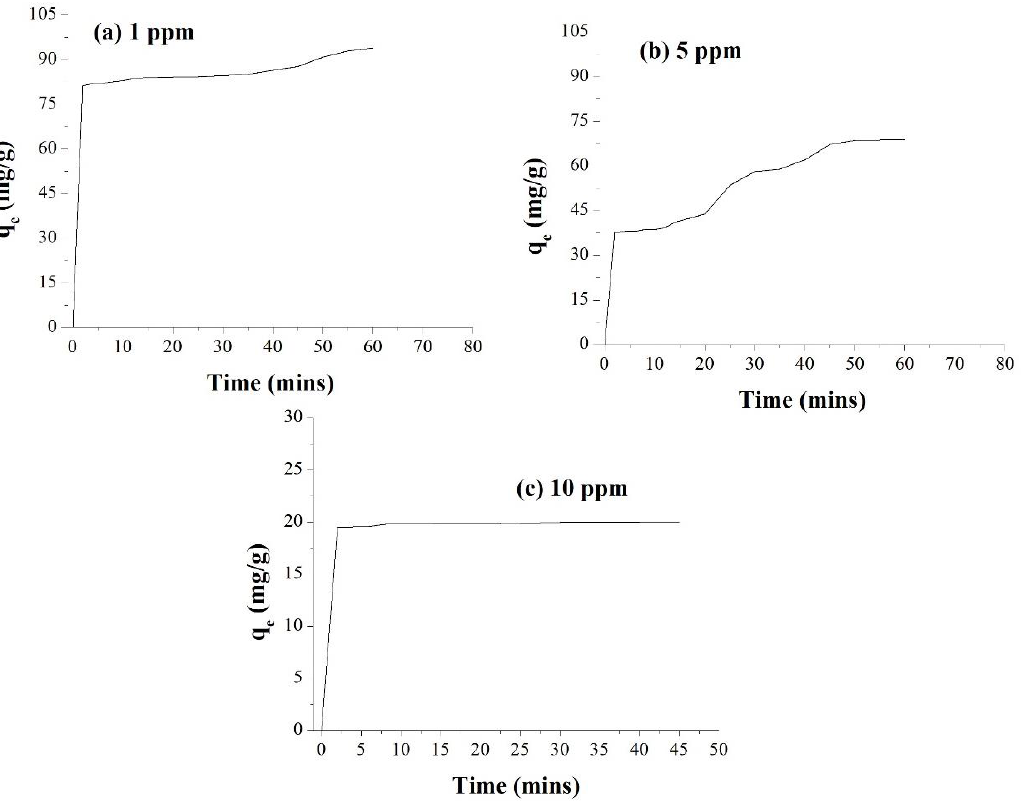
Figure 8. % Adsorption of the insecticide CP by free AgNPs at different initial AgNPs concentrations.